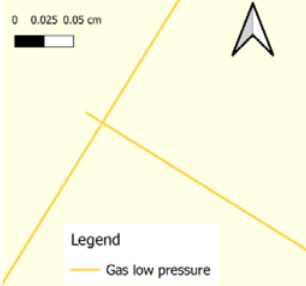
Figure 3. Example of a digitization error in geometries. An overshoot in the gas low pressure Figure 2. Example of the mapping between the classes ‘ SurroundingSoilProperties’ and ‘ GroundWaterProperties’ and the corresponding database table ( uom5_soil_and_groundwater represented in pink)